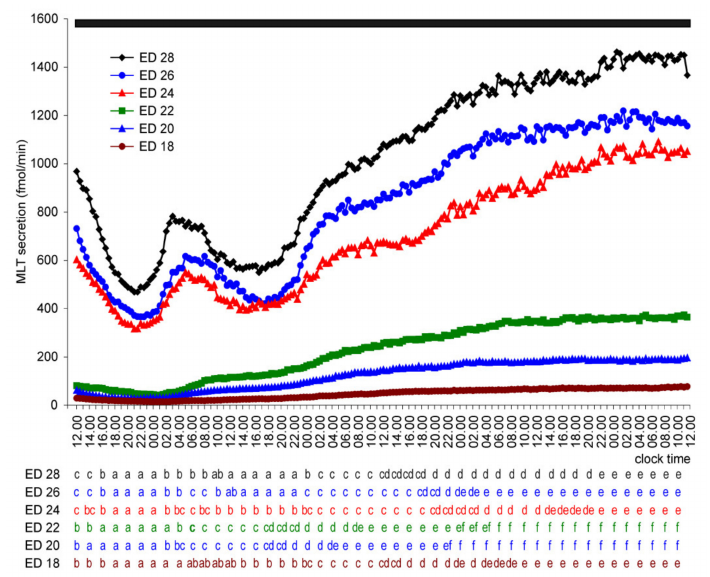
Figure 4. Secretion of MLT (means, n = 4) from pineal organs of goose embryos incubated under continuous darkness. Letters show differences between time-points within a group of explants pre- pared from embryos of the same age. The identical letters indicate means, which are not significantly